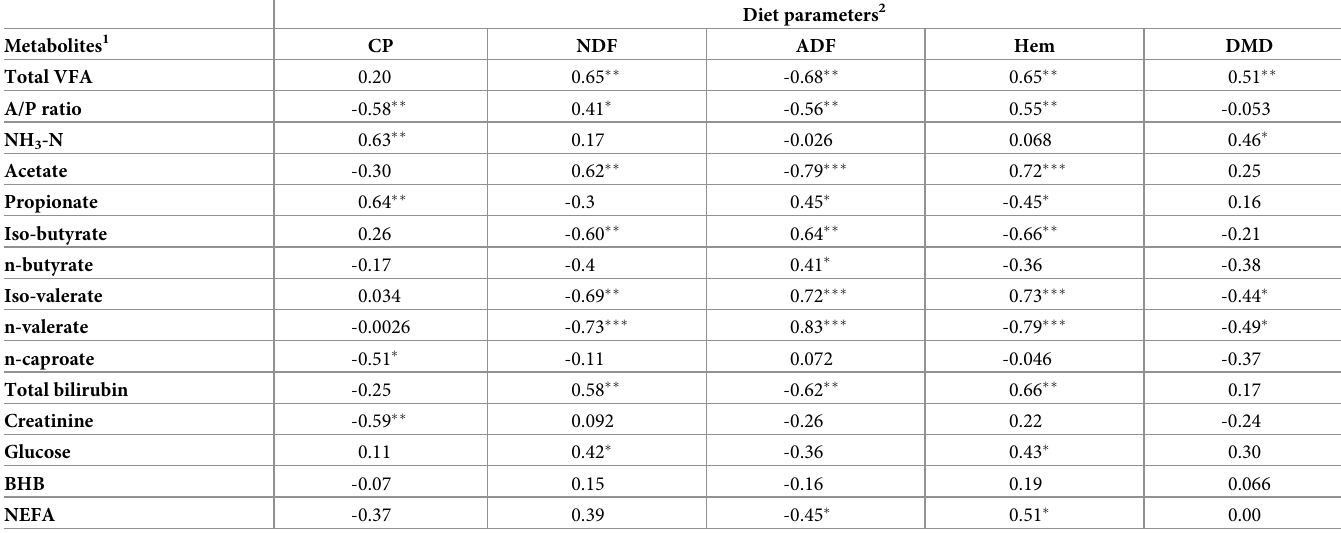
Table 8. Residual correlation coefficients between diet, rumen and plasma metabolite